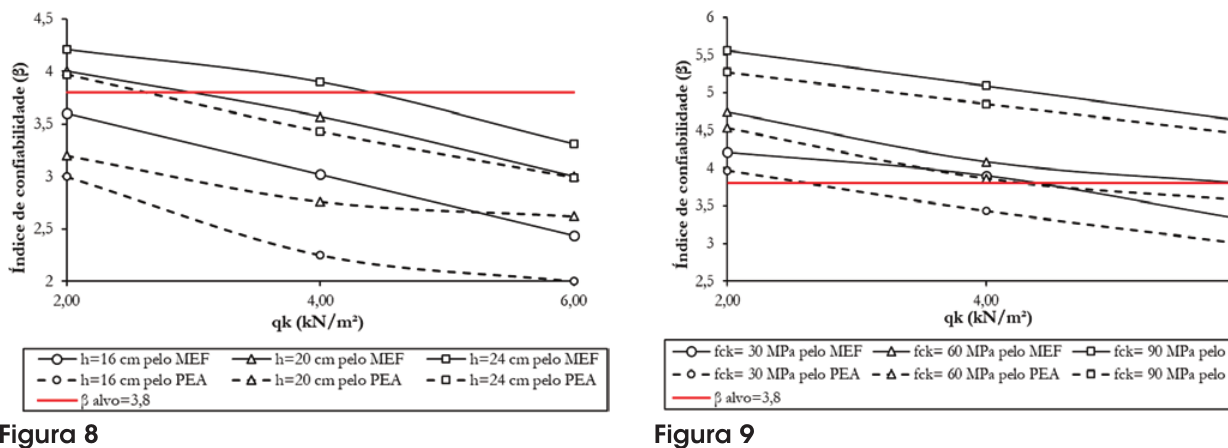
Análise do índice de confiabilidade para as lajes com altura=24